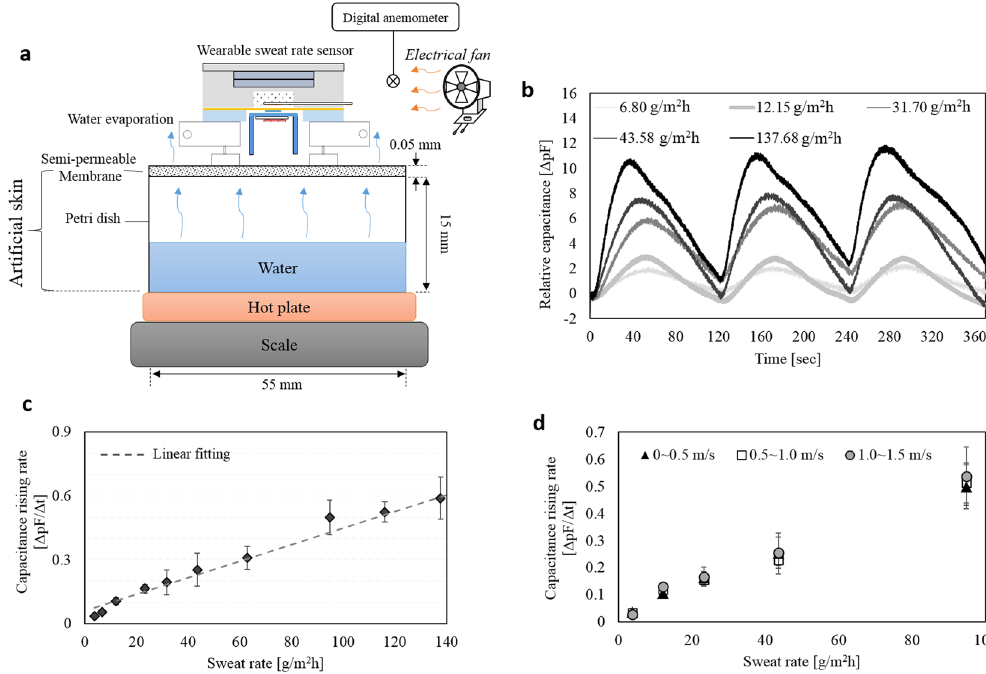
Figure 5. Artificial skin experiment: ( a ) experimental setup for the watch-type sweat rate sensor characterization; ( b ) time-dependent relative capacitance in the five different sweat rate conditions during three measurement cycles; ( c ) capacitance rising rate depending on the sweat rate ranging from 3.76 g/m 2 h to 137.68 g/m 2 h; ( d ) capacitance rising rate depending on the sweat rate, in the three different air velocity conditions in the ranges of 0~0.5 m/s, 0.5~1.0 m/s, and 1.0~1.5